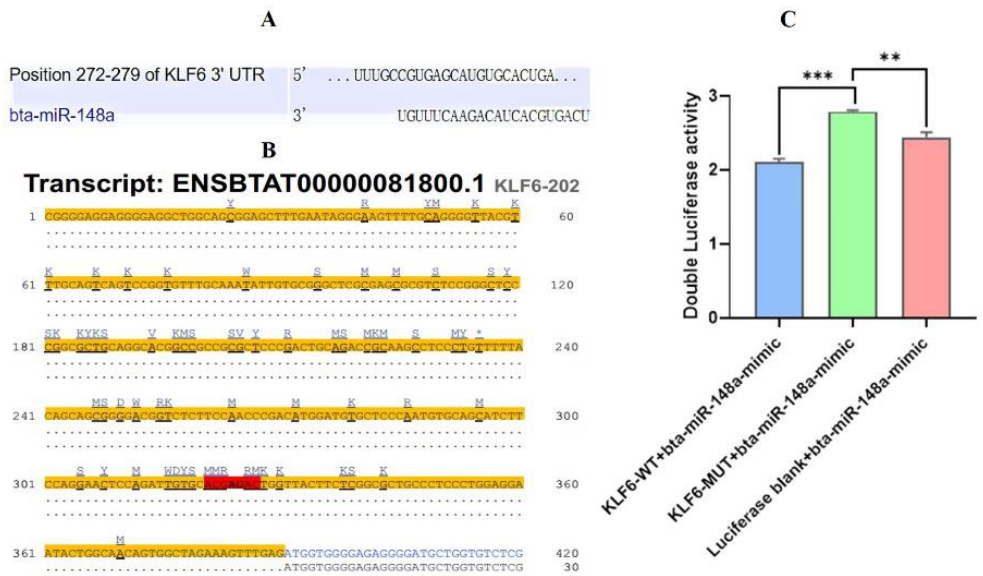
Figure 4. Bioinformatics analysis and dual-luciferase reporter assay. ( A ), Binding site matching in white highlighted area for bta-miR-148a and 3’-UTR KLF6 mRNA. ( B ), Binding site matching results in 3’-UTR KLF6 mRNA for bta-miR-148a highlighted in red. The yellow highlighted sequence represents the 3’-UTR of KLF6 mRNA. ( C ); Dual-luciferase reporter assay representing the target site validation. ** p < 0.01, *** p < 0.001.